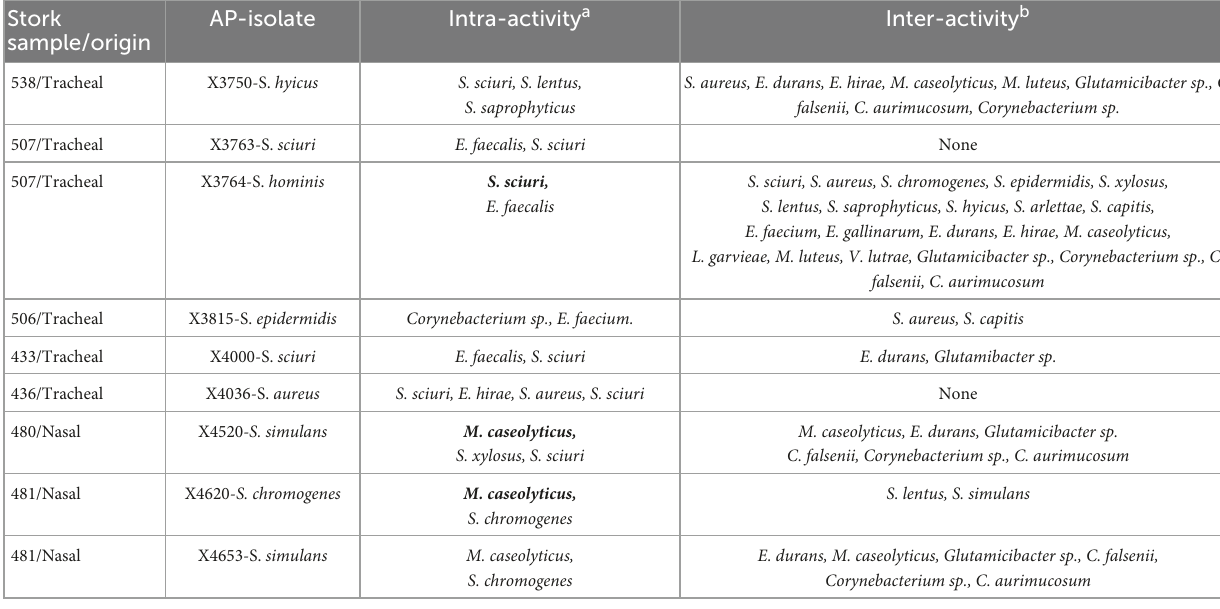
TABLE 2 Activity of the antimicrobial-producing (AP) isolates against Gram-positive (G + ) bacteria cohabiting in the same stork (intra-activity) or representative of the nasotracheal microbiota of the storks